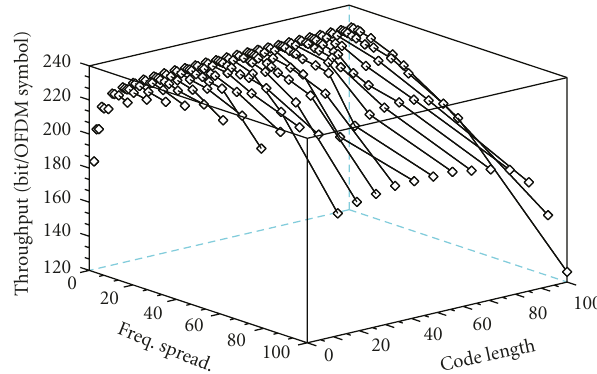
Figure 6: Throughput R/L t versus code length L and frequency spreading factor L f over 100 subcarriers, with an average SNR of 20 dB and Γ = 6